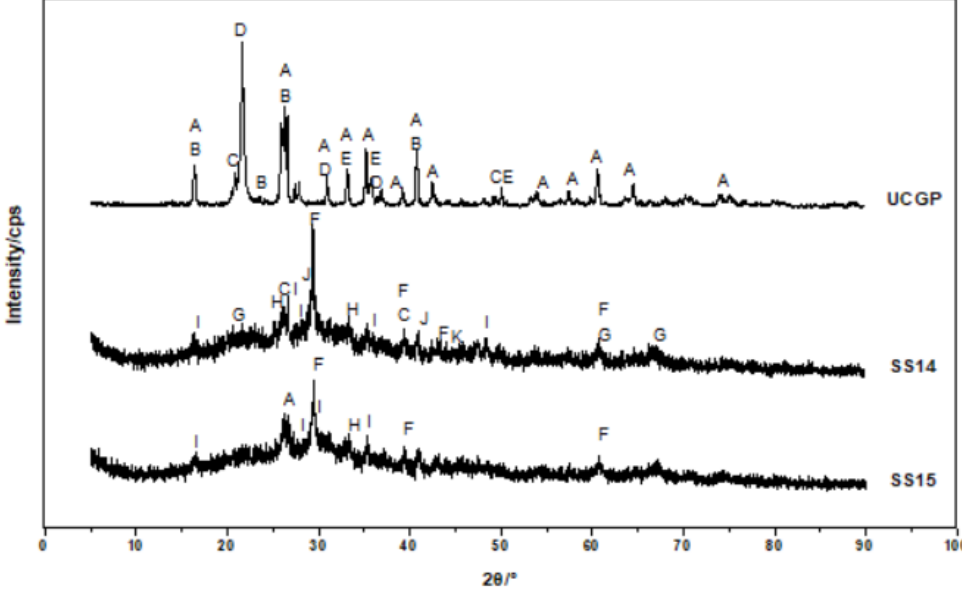
Figure 12. XRD spectrums of SS14, SS15 and UCGP. A. Mullite B. Sillimanite C. Quartz D. Cristobalite E. Hematite F. Calcite G. Nepheline H. Analcime I. Calcium sodium aluminum zeolite J. Gehlenite K. Grossular.